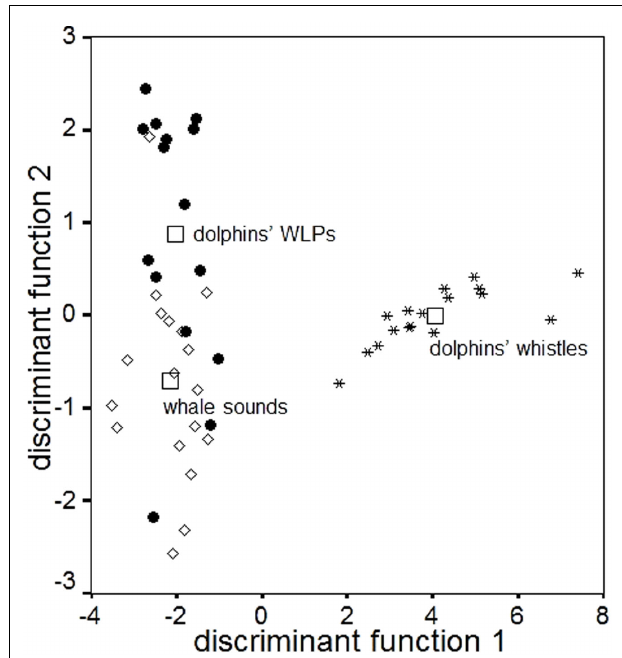
FIGURE 2 | Scatter plot of the discriminant function analysis comparing several acoustic parameters of dolphins’ whistles (asterisks), dolphins’WLPs (black dots), and humpback whale sounds (white diamonds). Squares indicate the group means. Discriminant function 1 corresponds to minimum frequency (canonical correlation coefficient = 0.949;Wilks- λ = 0.069; P ≤ 0.001); discriminant function 2 corresponds to number of harmonics (canonical correlation coefficient = 0.551;Wilks- λ = 0.696; P = 0.001).